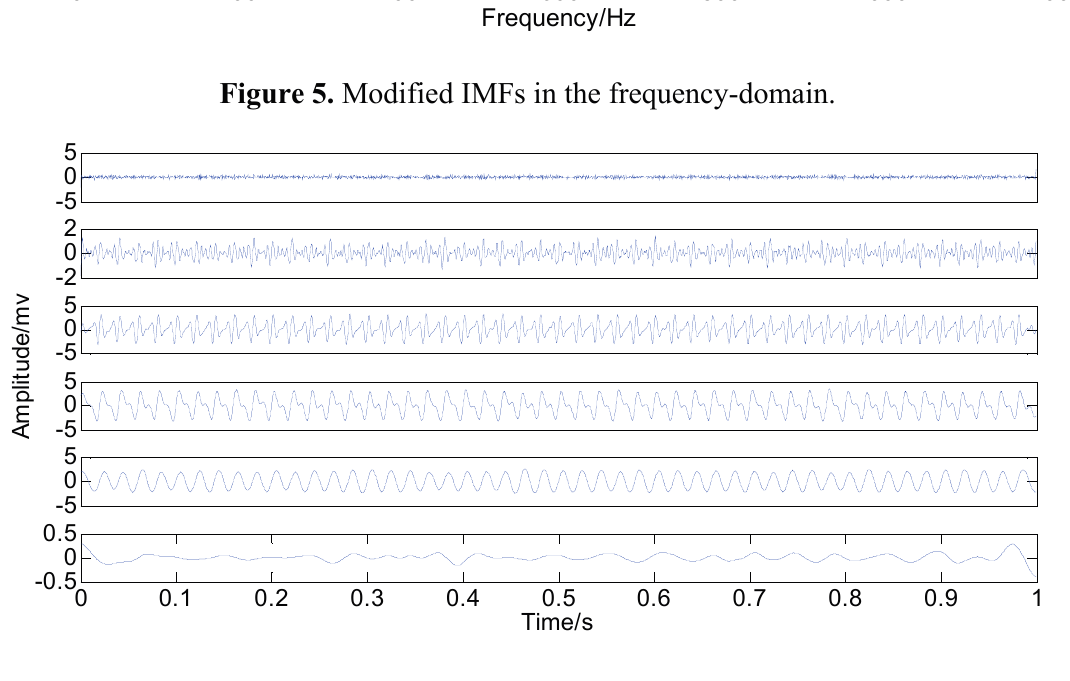
Figure 6. Original IMFs in the